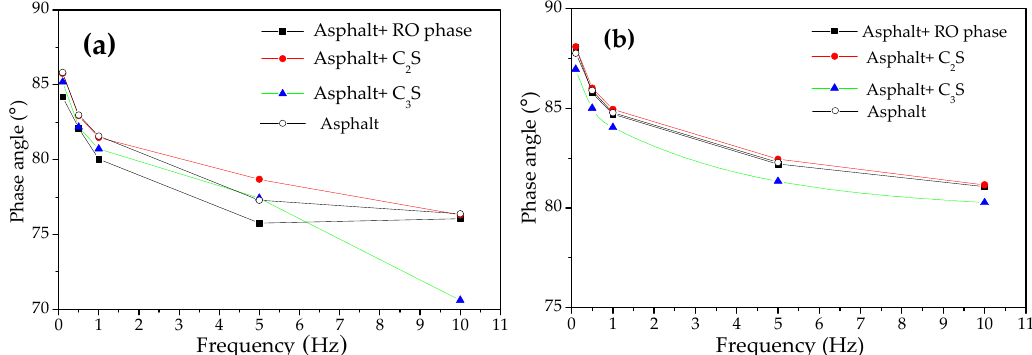
Figure 13. Phase angles of the asphalt and mixtures of C 2 S, C 3 S, and RO at different temperatures. ( a ) The temperature was 45 ℃ , ( b ) The temperature was 55 ℃ .